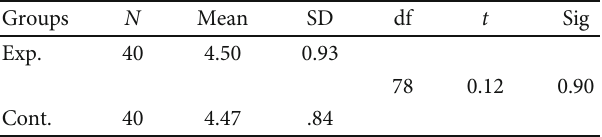
Table 2: Experimental and control group pretest results. Groups